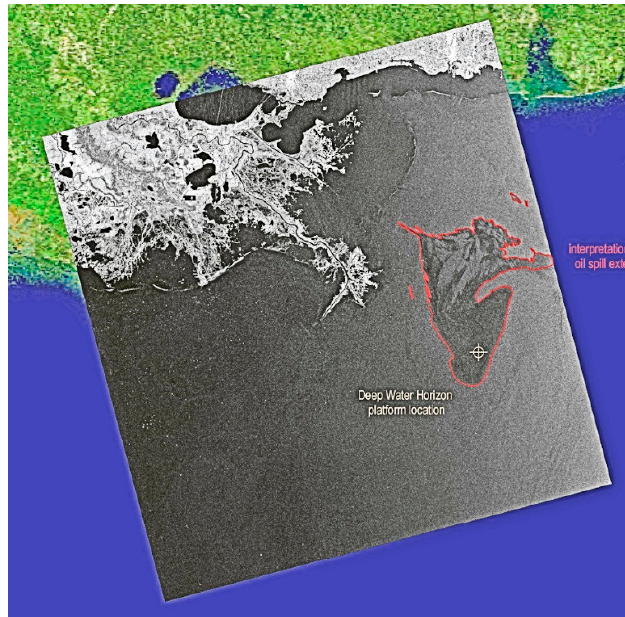
Figure 9. RADARSAT-2 image of the Gulf oil spill. The red outline shows the spill. The shoreline is shown as white and the colored portions derive from a visible satellite image (Image from Canadian Space Agency website http://www.asc-csa.gc.ca/images).